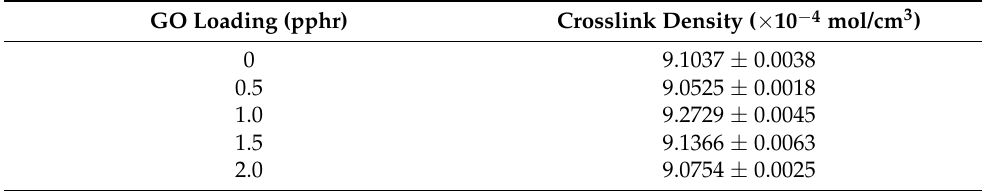
Figure 3. XRD pattern of GO, Pure NBR, and NBR-GO membranes at different GO loadings. All the membranes contain 1.0 pphr sulphur and are being crosslinked at the same temperature and time duration. Crosslinks form a stable three-dimensional sulphide network between the NBR polymeric chains. These linkages impart high mechanical strength and chemical resistance to the membrane. The crosslink density in each membrane is shown in Table 2. GO loading was found not to influence the crosslink density as the crosslink density between all the samples was almost similar to one another. Table 2. Crosslink density of the membranes.